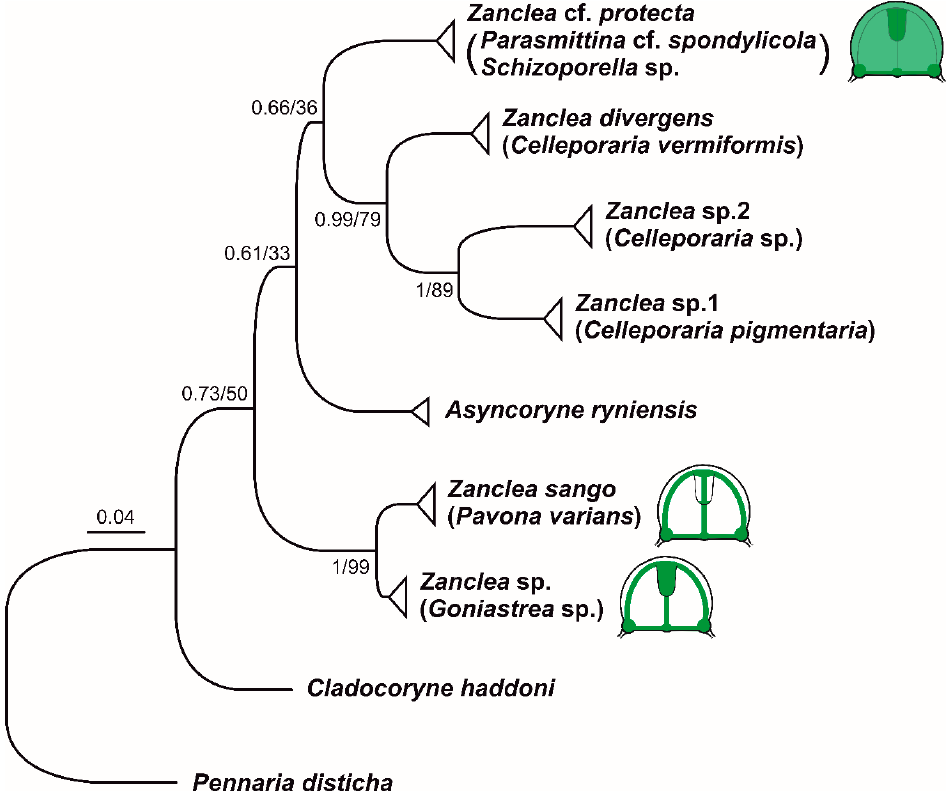
Figure 9. 16S rRNA phylogeny of the species included in the analyses. Numbers at nodes represent Bayesian posterior probabilities and maximum likelihood bootstrap values, respectively. Hosts for each species are in brackets. Schematic drawings of fluorescence patterns in Zanclea medusae are also represented.